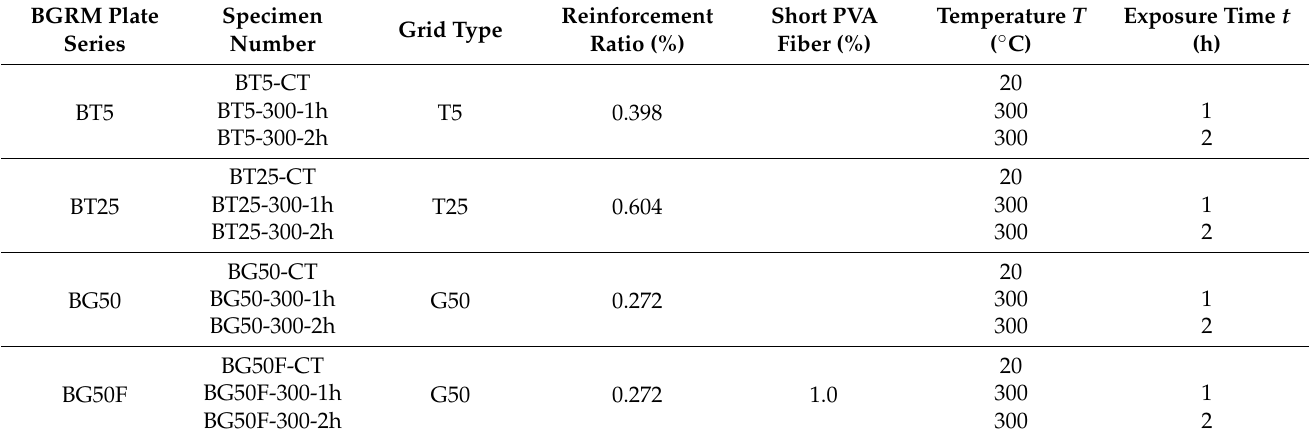
Table 2. Details of tensile